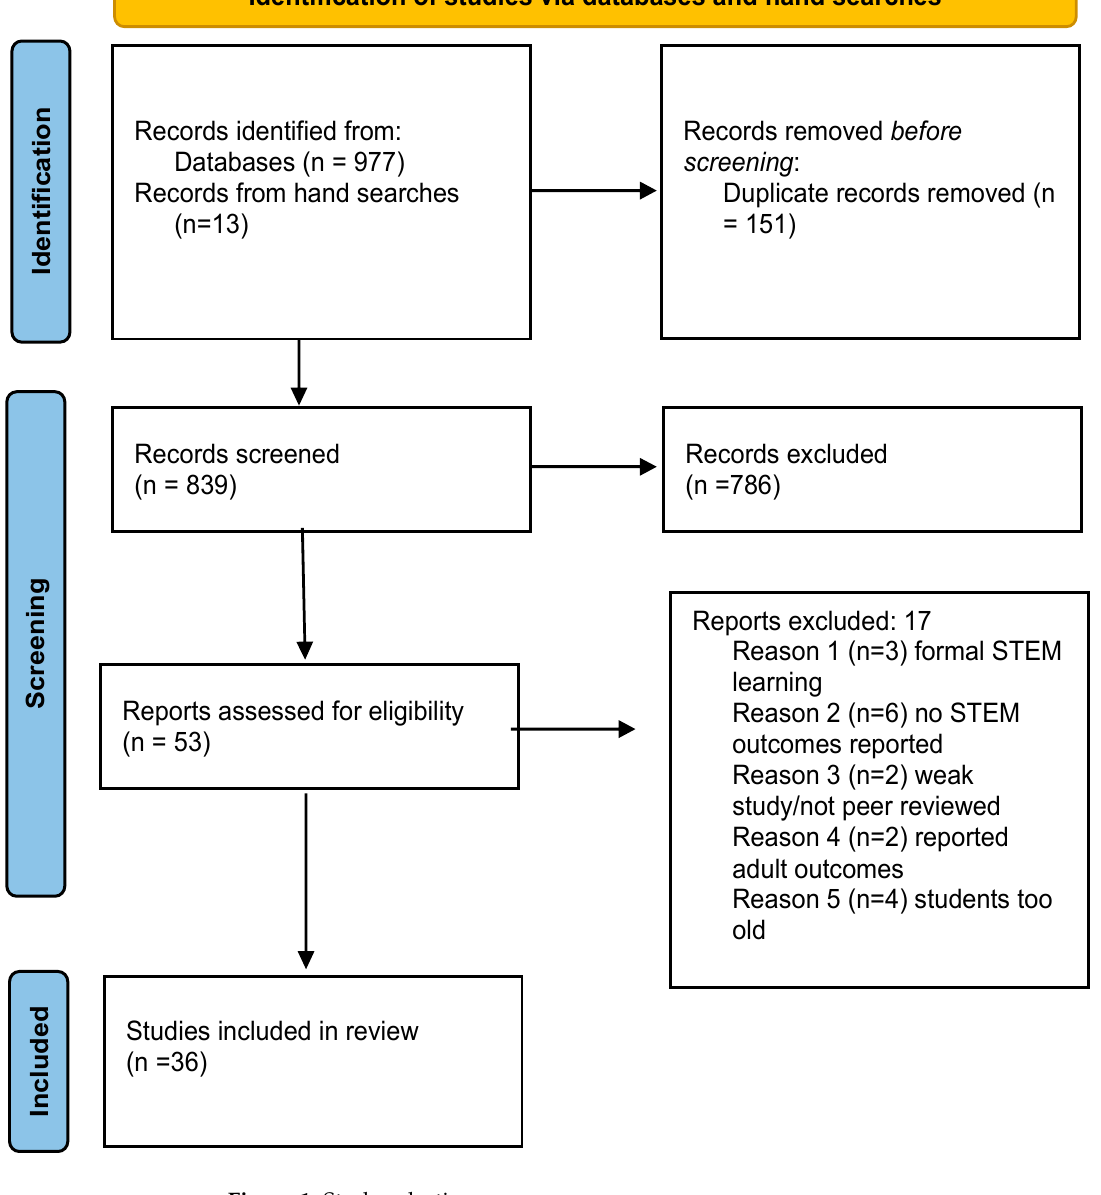
Figure 1. Study selection